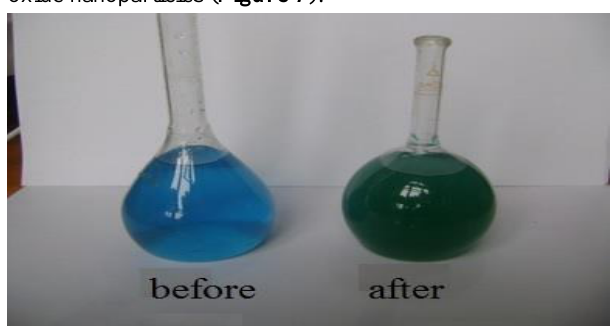
Figure 7. Images of copper sulfate solutions in distilled water before and after plasma treatment of a nanosecond discharge in air at atmospheric pressure.